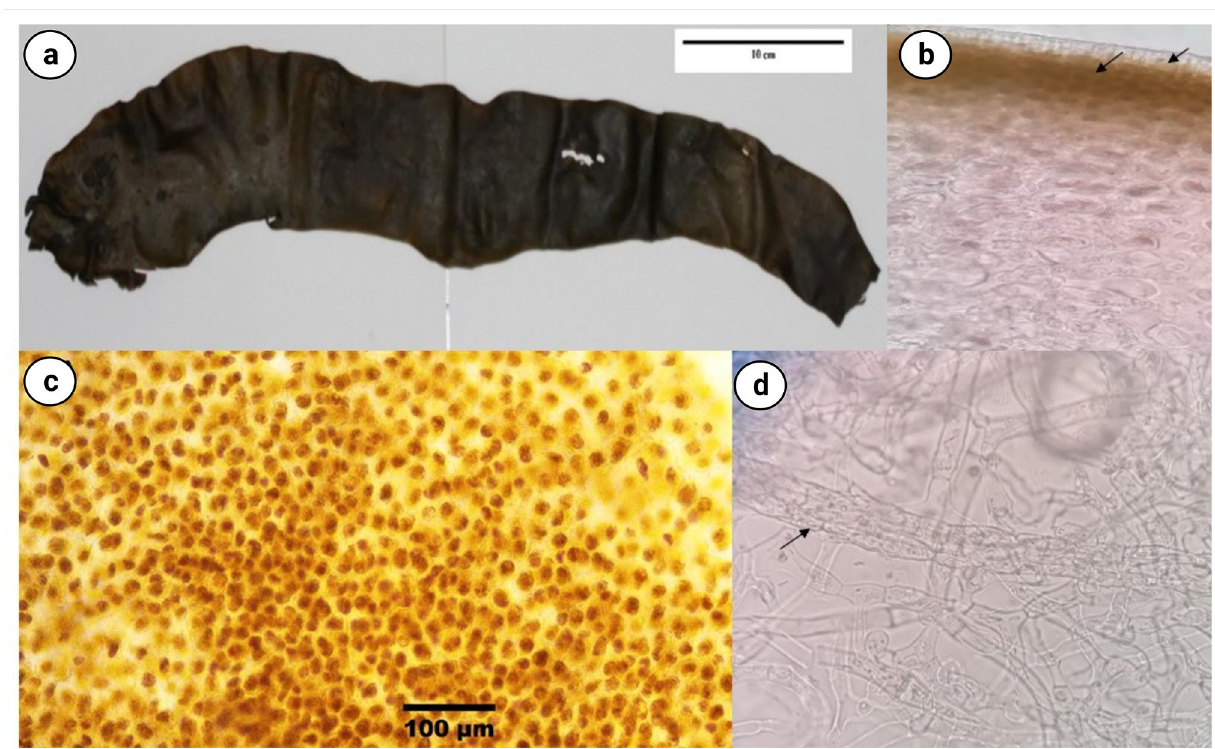
Fig 1. Morphological images of Himantothallus grandifolius . (a) External morphology of the thallus. (b) Margin of the blade showing meristoderm (inner arrow), subtending cortical cells (outer arrow), and a network of cortical filaments (40X). (c) Cells arrangement (10X). (1d) Plexus of unsheathed filaments intermingled with sheathed trumpet hyphae (arrow) that run in a longitudinal direction (40X).